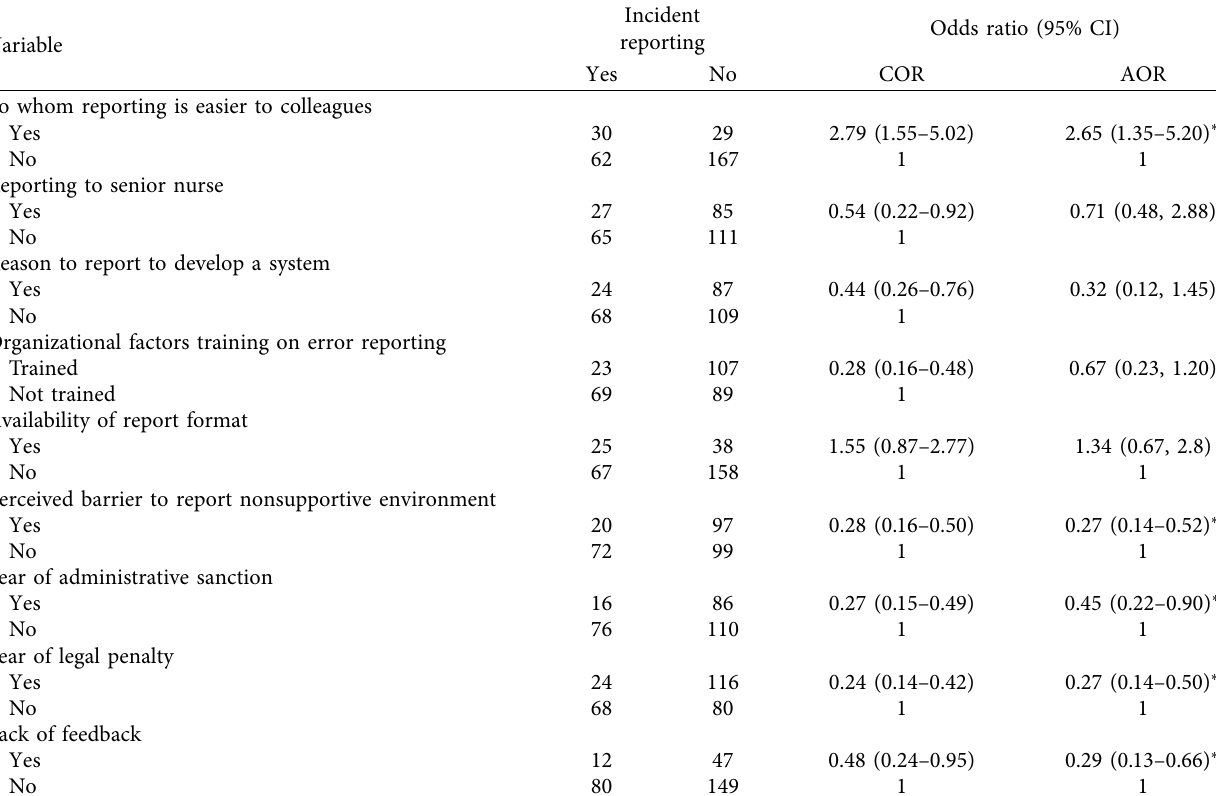
Table 2: Bivariable and multivariable analysis of incident reporting behaviors among nurses working in Amhara regional state referral hospitals, 2019 ( n �